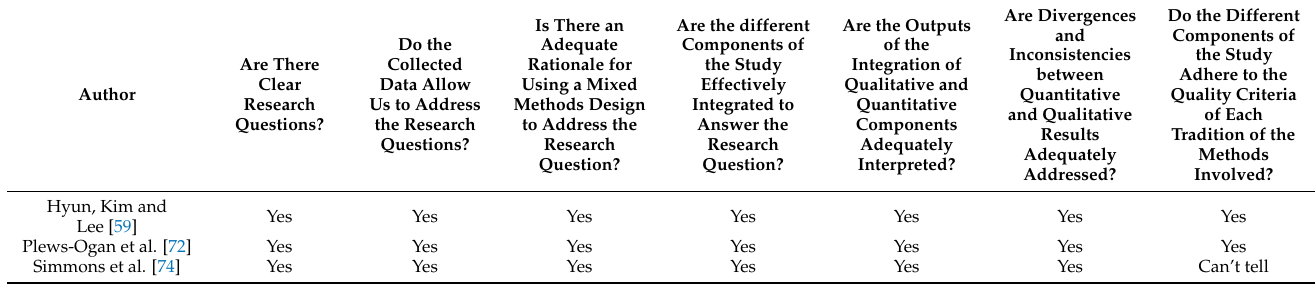
Table A4. Results of Mixed Methods Appraisal Tool (MMAT) Mixed Methods